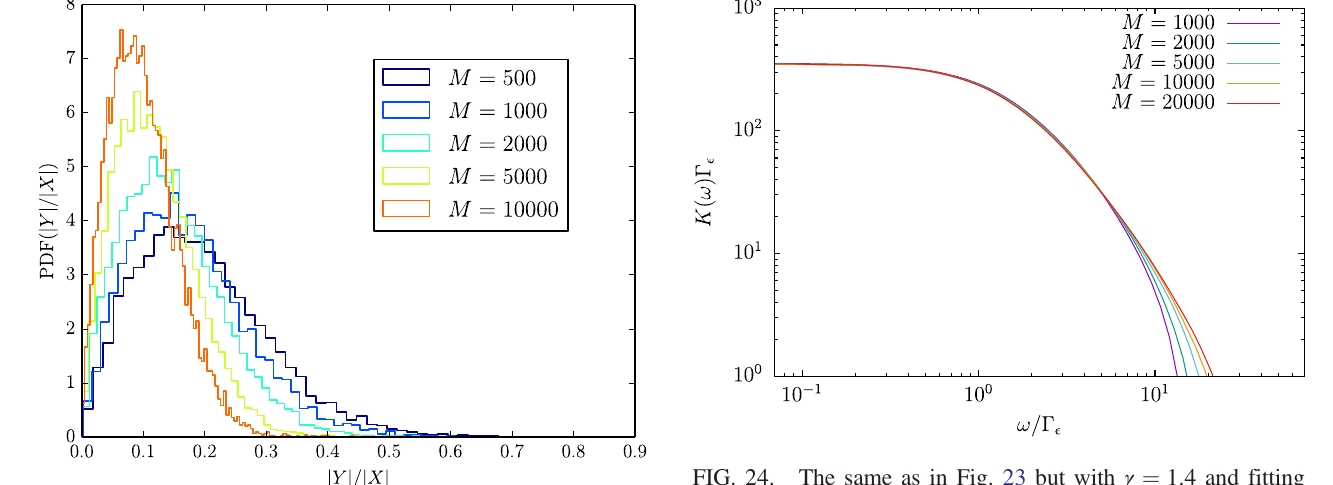
FIG. 24. The same as in Fig. 23 but with γ ¼ 1 . 4 and fitting exponent ε ¼ 0 . 04 .